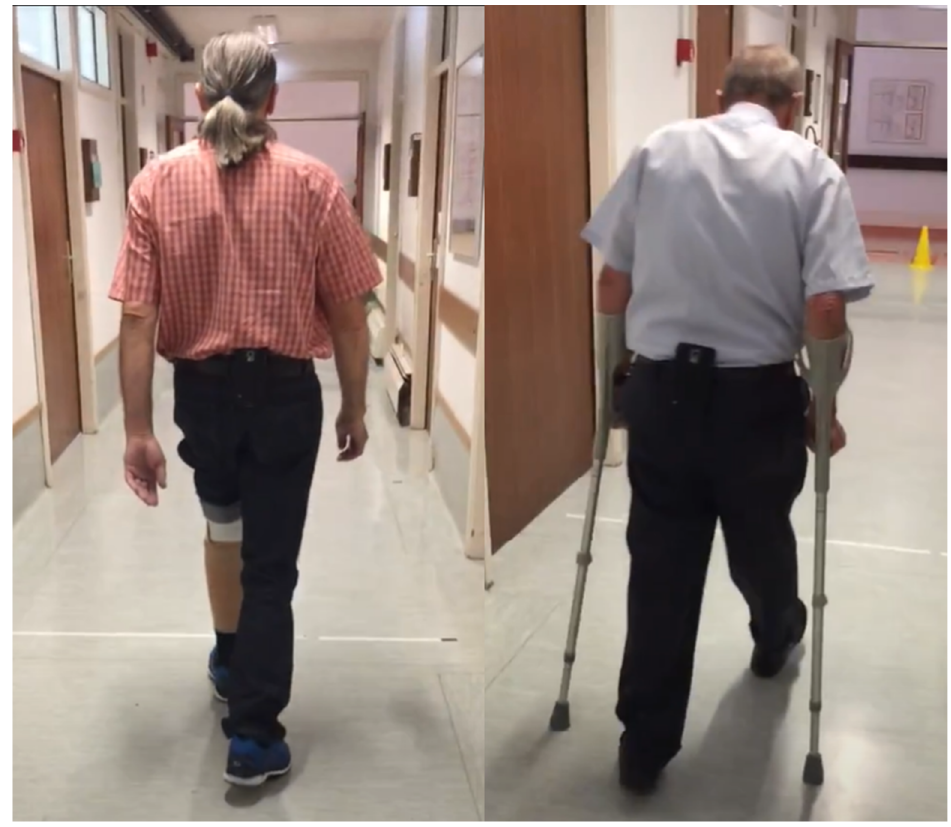
Figure 1. Experimental set-up: smartphone on posterior pelvis.